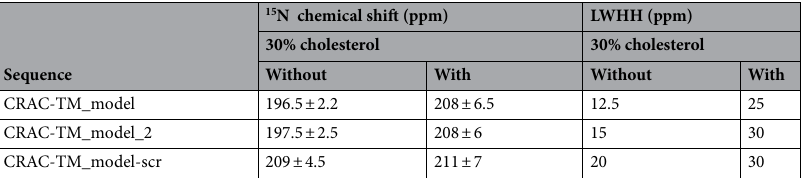
Table 2. 15 N chemical shift measurements of [ 15 N-Leu8]-CRAC-TM_model labelled with 15 N within the CRAC sequence, reconstituted into POPC lipid bilayers that were uniaxially oriented with the normal parallel to the magnetic field direction at peptide-to-lipid ratios of 2 mol% in the absence or presence of 30 mol% cholesterol. The errors in determining the chemical shift were derived from the spectral resolution, the line width and the signal-to-noise ratio. LWHH line width at half height.